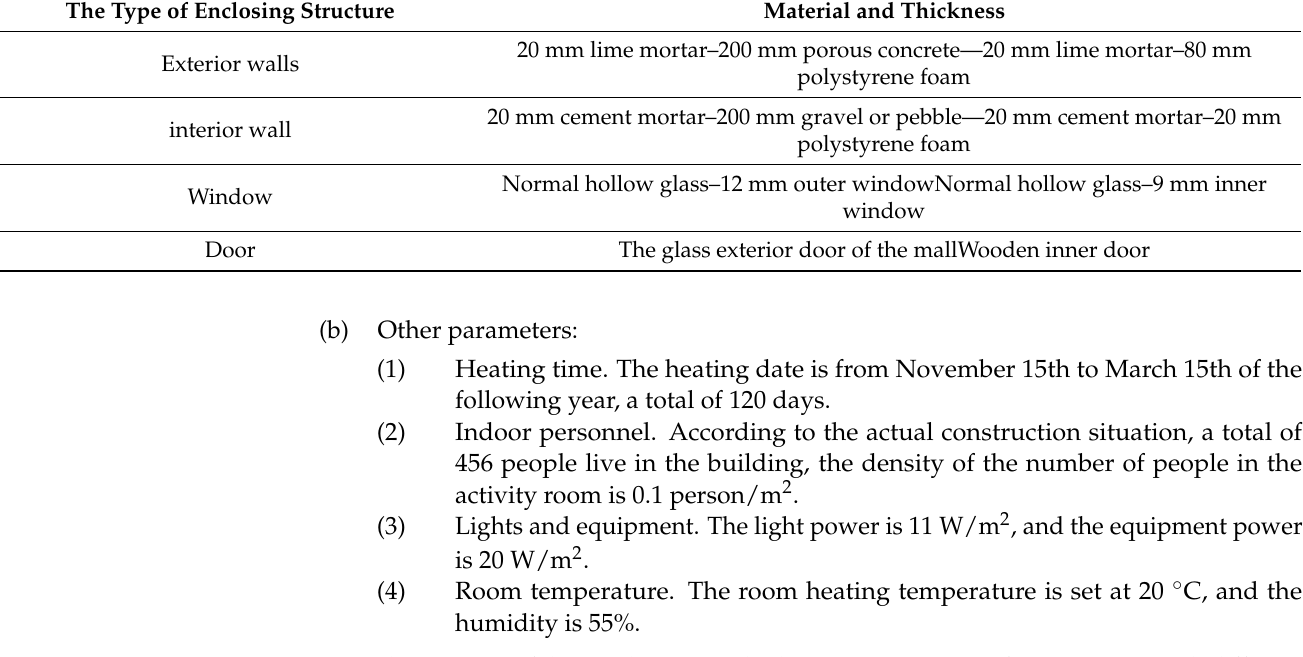
Table 1. Parameter of building enclosure.